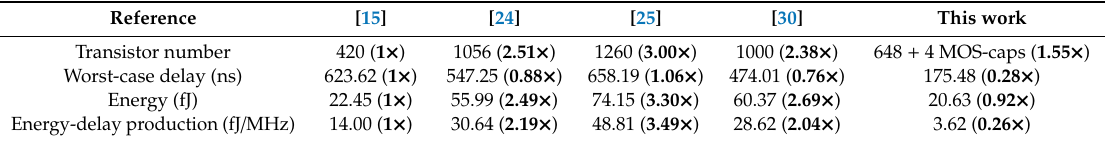
Table 2. Comparison with other works at 0.3 V (TT corner, 25 ◦ C).